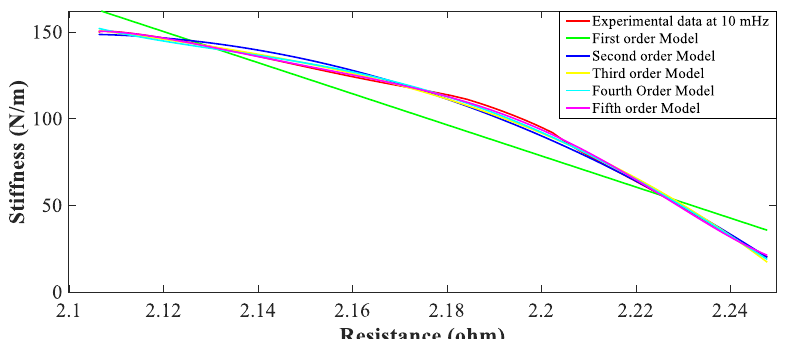
Figure 2. Polynomial model and experimental self-sensing variable stiffness actuation